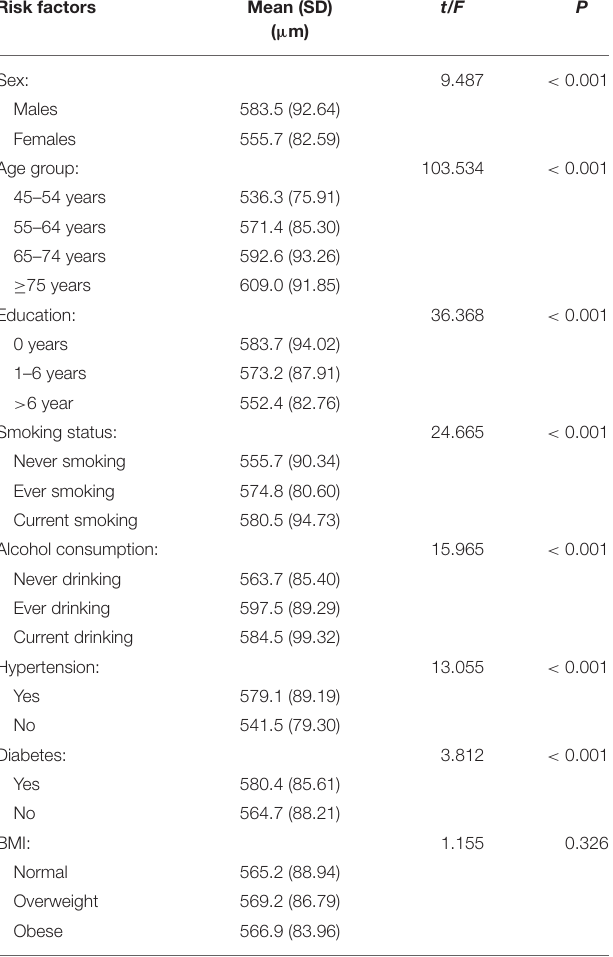
TABLE 3 | Association of mean carotid intima-media thickness with measured parameters in the linear regression analysis.